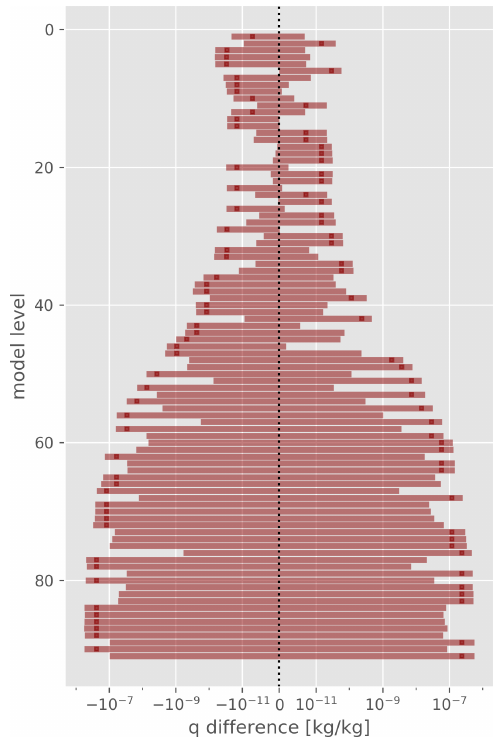
Figure 8. Maximal absolute errors (over grid points and time steps) for specific humidity for each model level. The error bars denote the error on the GRIB values obtained by evaluating Eq. (1).